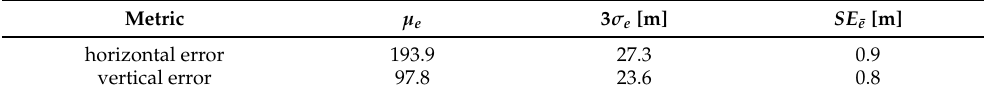
Table 3. Monte Carlo results for landing trajectory mean estimation